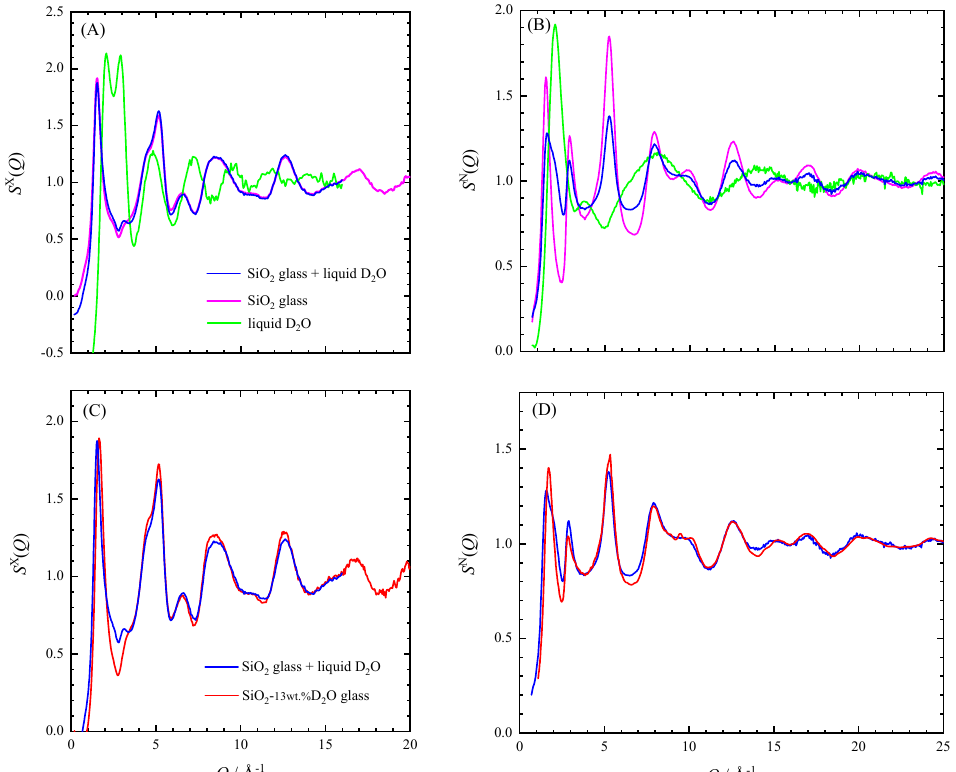
Figure 4. ( A ) S X ( Q )’s of SiO 2 glass and liquid D 2 O at ambient conditions [22,34], and that simulated for the hydrous glass using them. ( B ) Corresponding S ( Q ) for neutron, S N ( Q ) [33,35]. ( C ) Comparison of the observed and simulated S X ( Q )s for the hydrous SiO 2 glass. ( D ) Comparison of the observed and simulated S N ( Q )s.